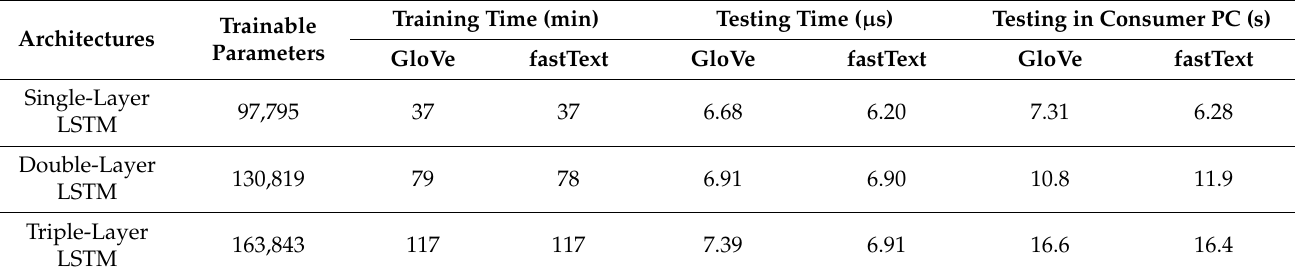
Table 8. LSTM architecture trainable parameters, and testing and training